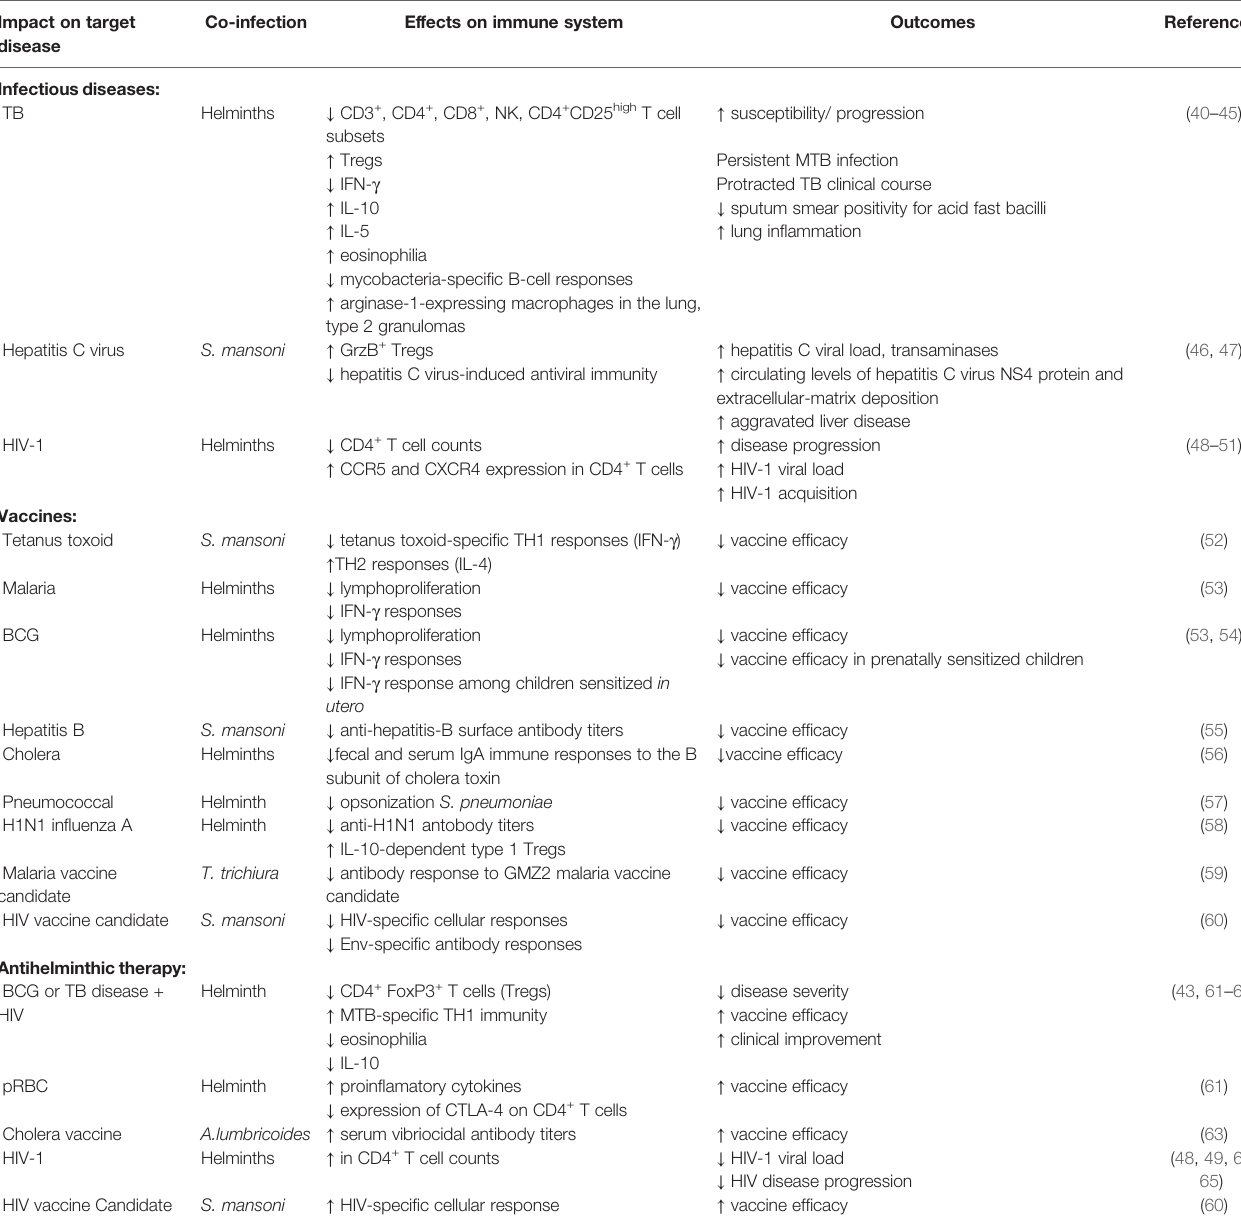
TABLE 1 | Summary of the helminth-induced hyporesponsive immune responses to heterologous infections and